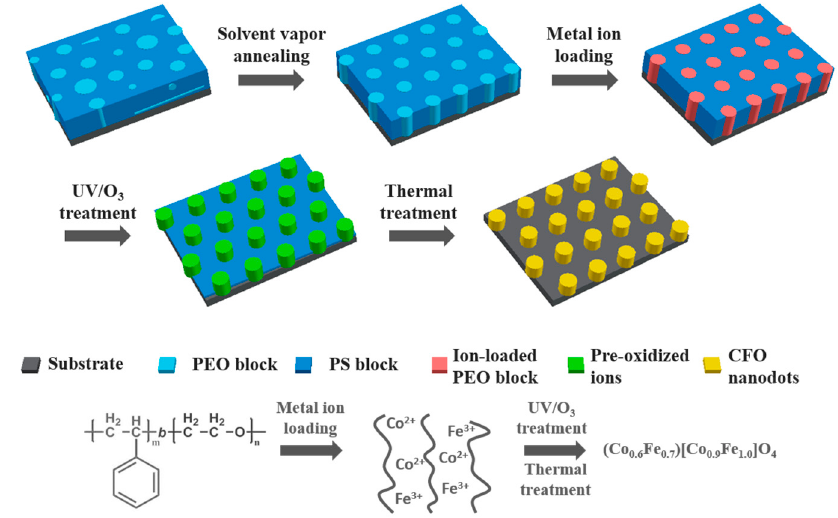
Figure 1. Schematic representation of the fabrication process of the cobalt ferrite (CFO) nanodots. Abbreviations: PEO, poly(ethylene oxide); PS, polystyrene; UV/O, ultraviolet/ozone.